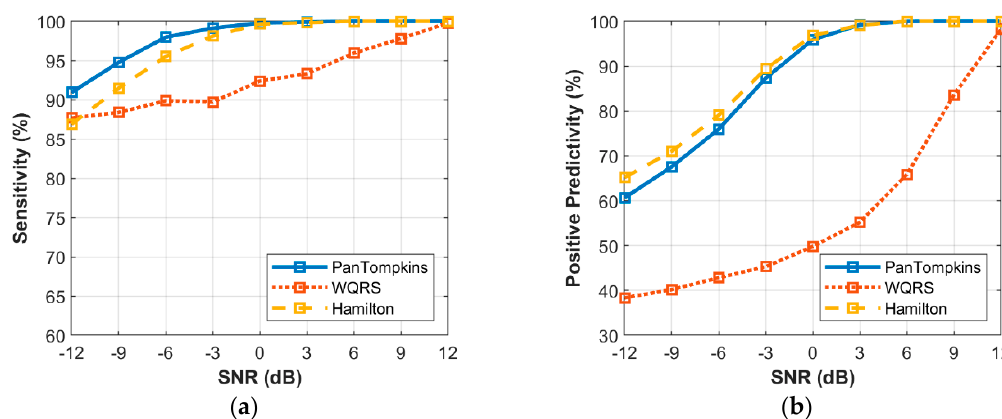
Figure 7. Relationship between the performance of beat detection and MA for the record 100: ( a ) sensitivity with SNR; ( b ) positive predictivity with SNR.